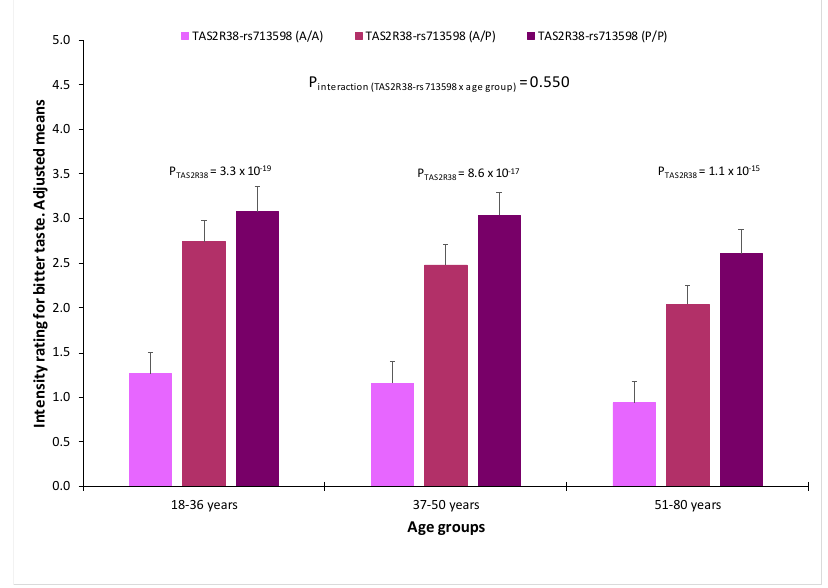
Figure 5. Bitter taste perception (intensity rating of PROP, 5.5 mM) in the whole population ( n = 949) by the TAS2R38 ‐ rs713598 polymorphism ( n = 304 for Ala/Ala, n = 464 for Ala/Pro and n = 177 for Pro/Pro) and age group. Means were adjusted for sex, age, diabetes, body mass index, smoking and medications (model 3). p ‐ values show the statistical significance of the TAS2R38 ‐ rs713598 polymorphism, in each age group, in the multivariate adjusted model 3. The p ‐ value for interaction term between the TAS2R38 ‐ rs713598 and age groups was additionally tested in model 3. Error bars are SE.